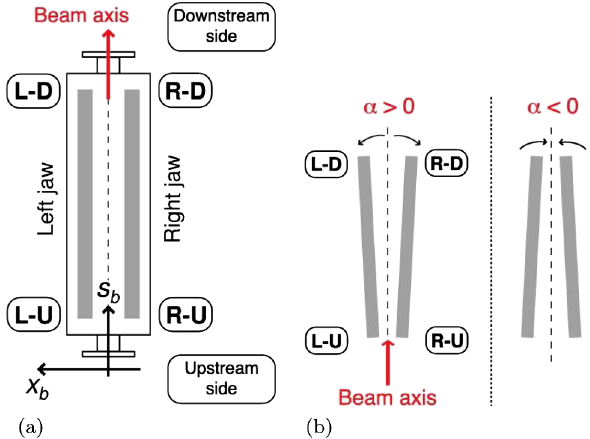
FIG. 3. The collimator coordinate system (a) and the jaw tilt angular convention (b) as viewed from above, from [20]. The four motors positioned at the edges of each jaw allow 4 degrees of